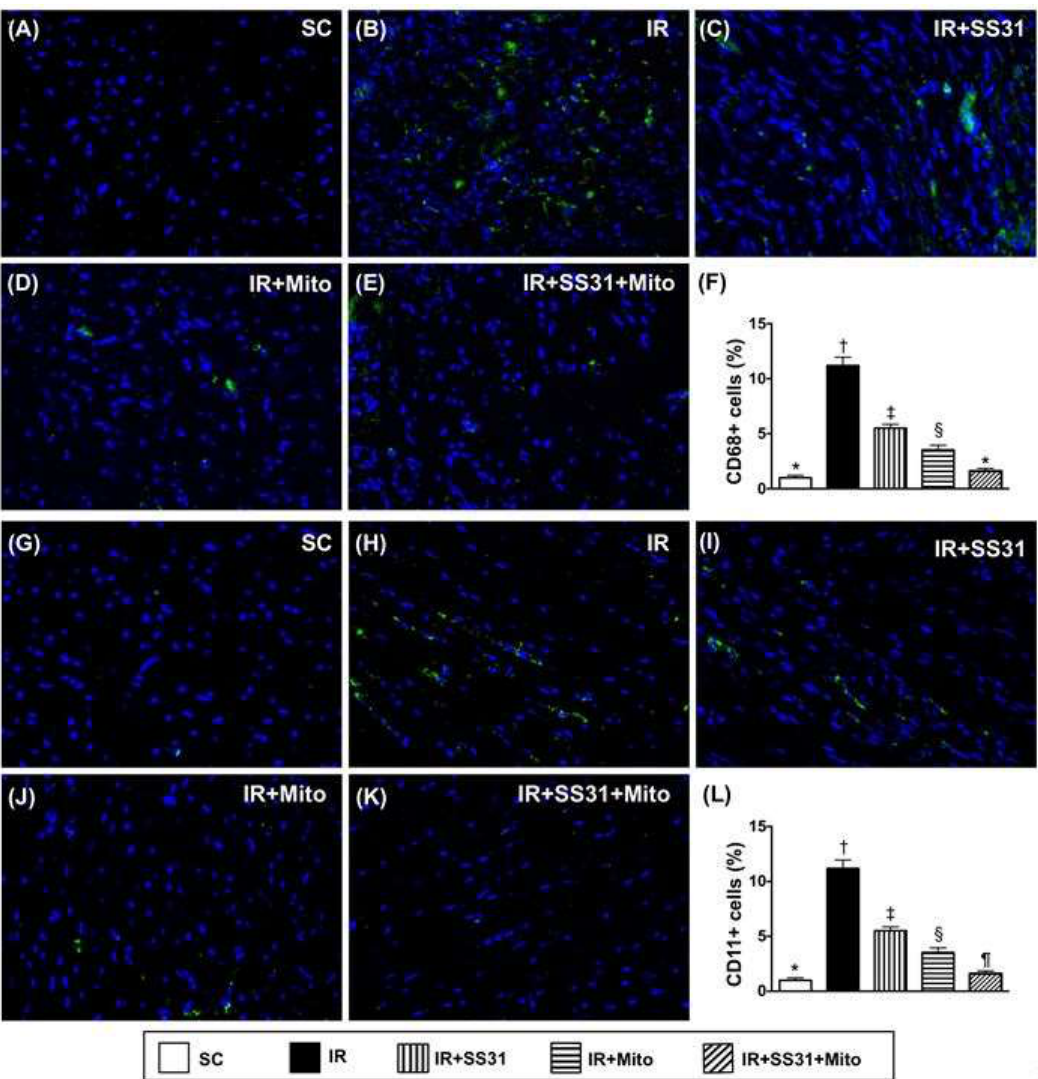
Figure 10. Inflammation in LV myocardium after the IR procedure. ( A – E ) Showing immunofluorescent (IF) microscopic finding (400×) of cellular expression of CD68 (green color). ( F ) Analytical result of number of CD68+ cells * vs. other groups with different symbols (†, ‡, §, ¶), p < 0.0001. ( G – K ) Illustration of IF microscopic finding (400×) of cellular expression of CD11 (green color). ( L ) Analytical result of number of CD11+ cells * vs. other groups with different symbols (†, ‡, §, ¶), p < 0.0001. Scale bars in the right lower corner represent 20 μm. All statistical analyses were performed by one-way ANOVA, which was followed by the Bonferroni multiple comparison post hoc test ( n = 8 for each group). Symbols (*, †, ‡, §, ¶) indicate significance at the 0.05 level. SC = sham control, IR = ischemia-reperfusion, and Mito = mitochondria.